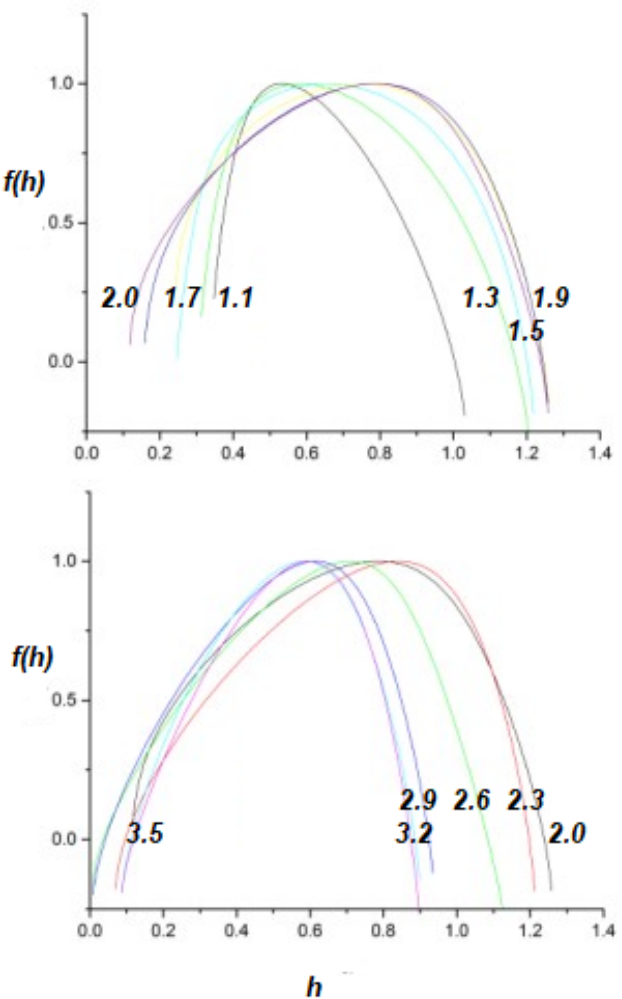
Figure 2. Effects of truncation on the spectra. ( Upper ): Increasing µ from 1.1 to 2.0 the spectral peak Figure 2: E⁄ects of truncation on the spectra. Upper: Increasing (cid:22) from 1.1 to moves to increasing h , in contrast with Figure 1. ( Lower ): Increasing µ from 2.0 to 3.5 the spectral 2.0 the spectral peak moves to increasing h , in contrast with Figure 1. Lower: Increasing (cid:22) from 2.0 to 3.5 the spectral peak moves to decreasing h: From [94] peak moves to decreasing h . From [96] with with permission.